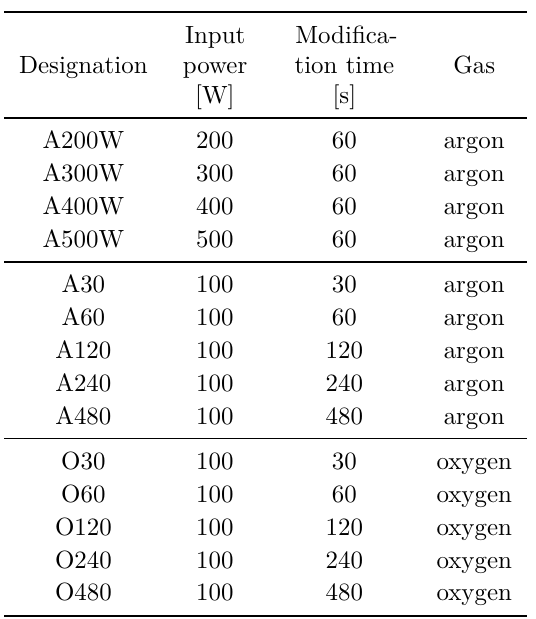
Table 2. Designation and device settings during plasma treatment of